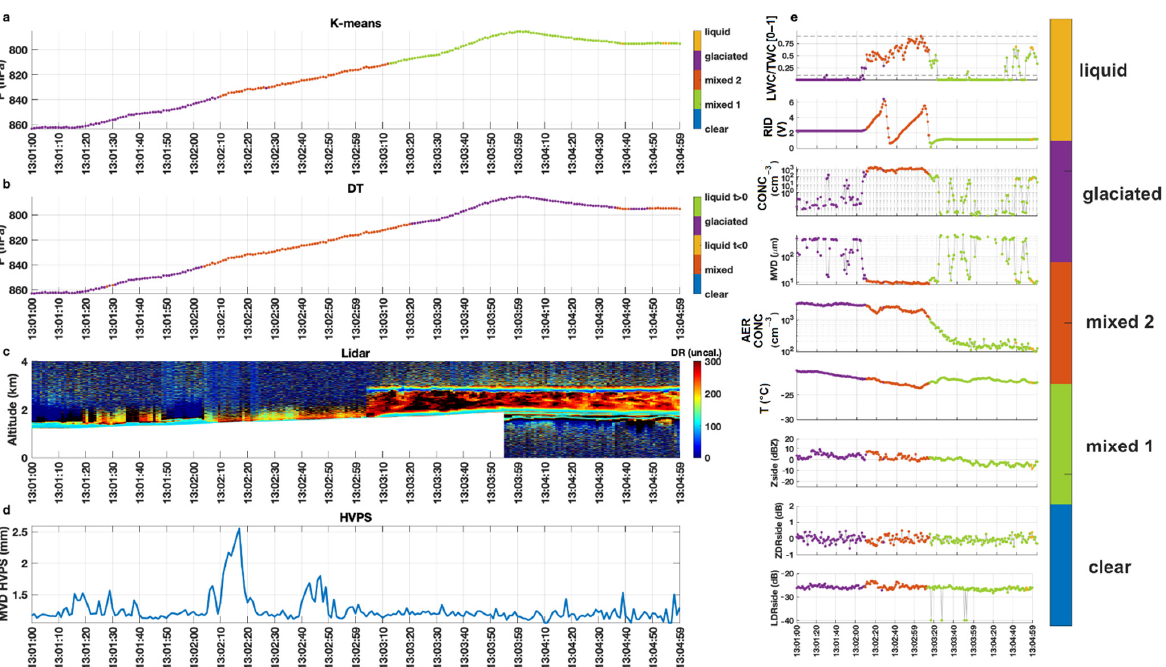
Figure 15. Test case time series (13:01–13:05 UTC) for intercomparison between k-means and DT algo- rithms classification of mixed and glaciated phases in F28: ( a ) aircraft pressure-altitude color-coded according to class assignments with k-means, ( b ) aircraft pressure-altitude color-coded according to class assignments with DT, ( c ) lidar depolarization ratio, ( d ) HVPS-3 MVD > 1 mm, ( e ) selected input parameters used for classification, color coded according to class assignments with